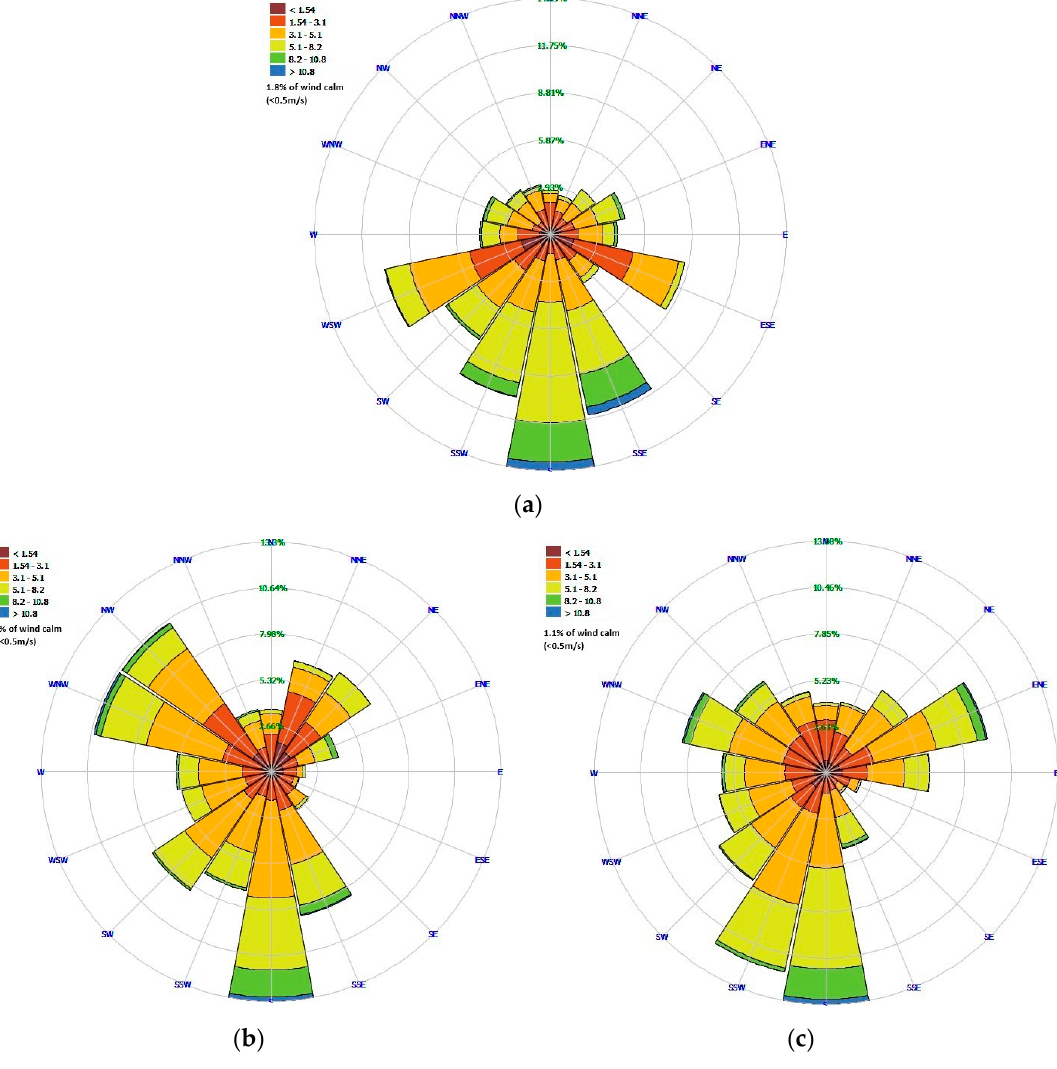
Figure 8. The distribution of wind directions and wind speeds determined by the WRF/CALMET model in the meshes of the meteorological grid corresponding to the location of selected towns in 2018 (Source : Own study): ( a ) Bogatynia, ( b ) Sieniawka, ( c ) Dzia ł oszyn.